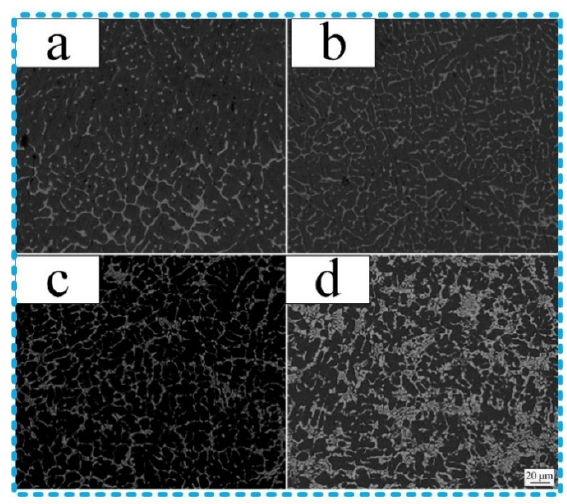
Figure 6. Microstructure of the butt joints ( I main = 60 A). ( a ) ER1100 filler wires; ( b ) ER5356 filler wires; ( c ) ER4043 filler wires; ( d ) ER4047 filler wires.